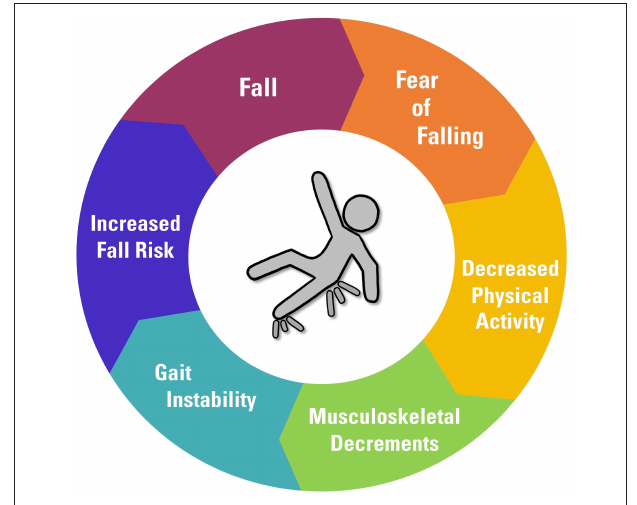
FIGURE 2 | The cycle of